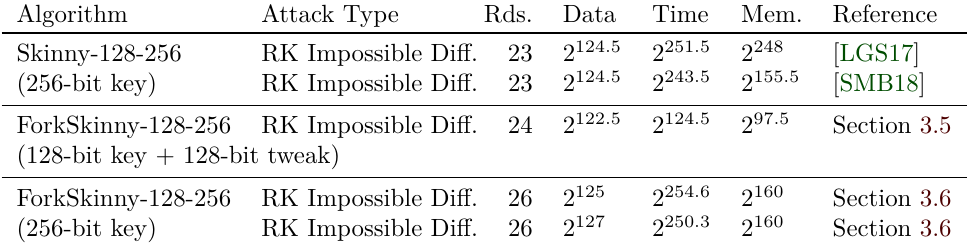
Table 2: Cryptanalysis results against Skinny and